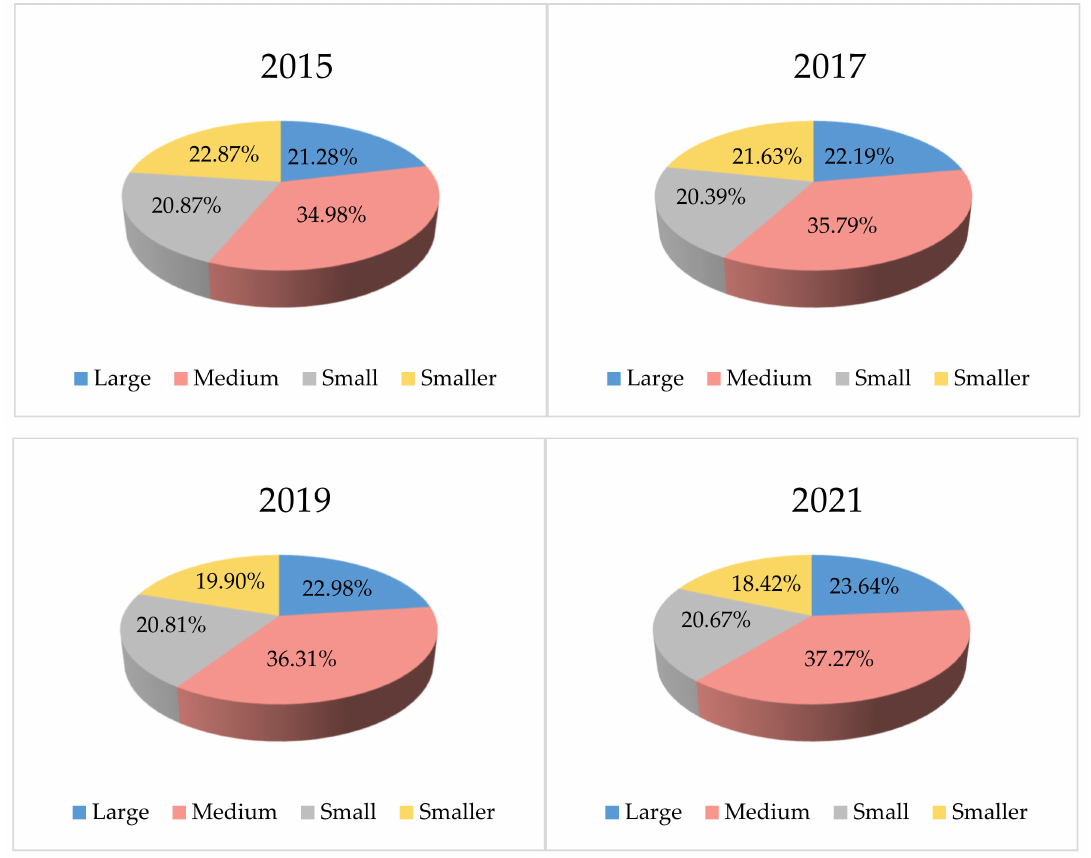
Figure 15. Changes in proportion of lake areas at different scales.